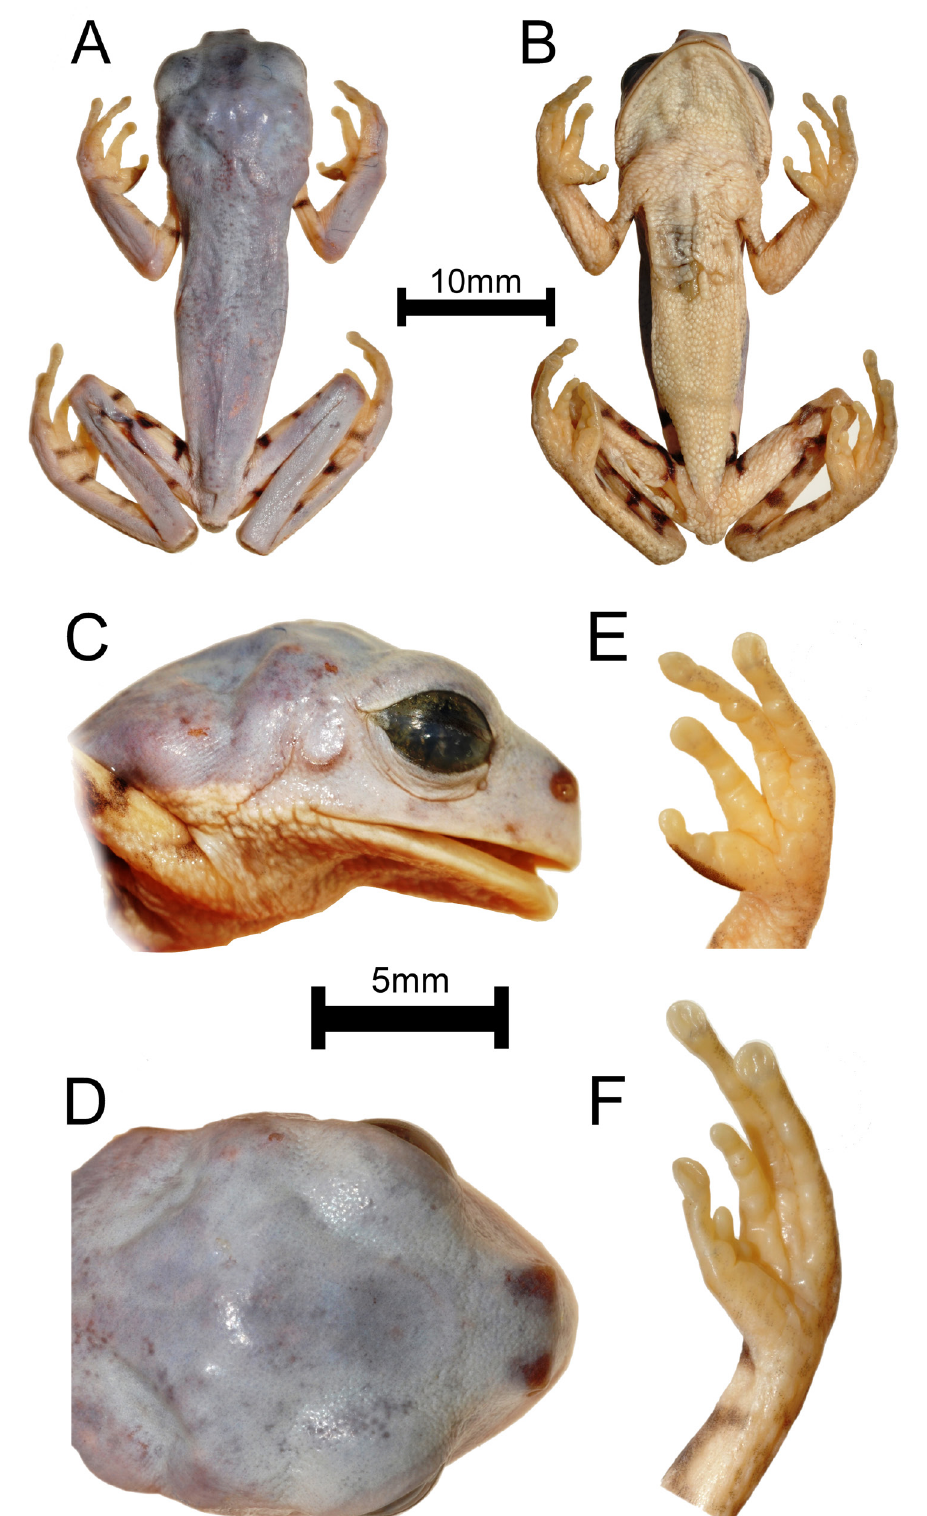
Fig. 2. Pithecopus gonzagai sp. nov., adult ♂, holotype (ZUEC 19685; SVL = 32.7 mm). A . Dorsal view. B . Ventral view. C . Head, lateral view. D . Head, dorsal view. E . Hand, ventral view. F . Foot, ventral